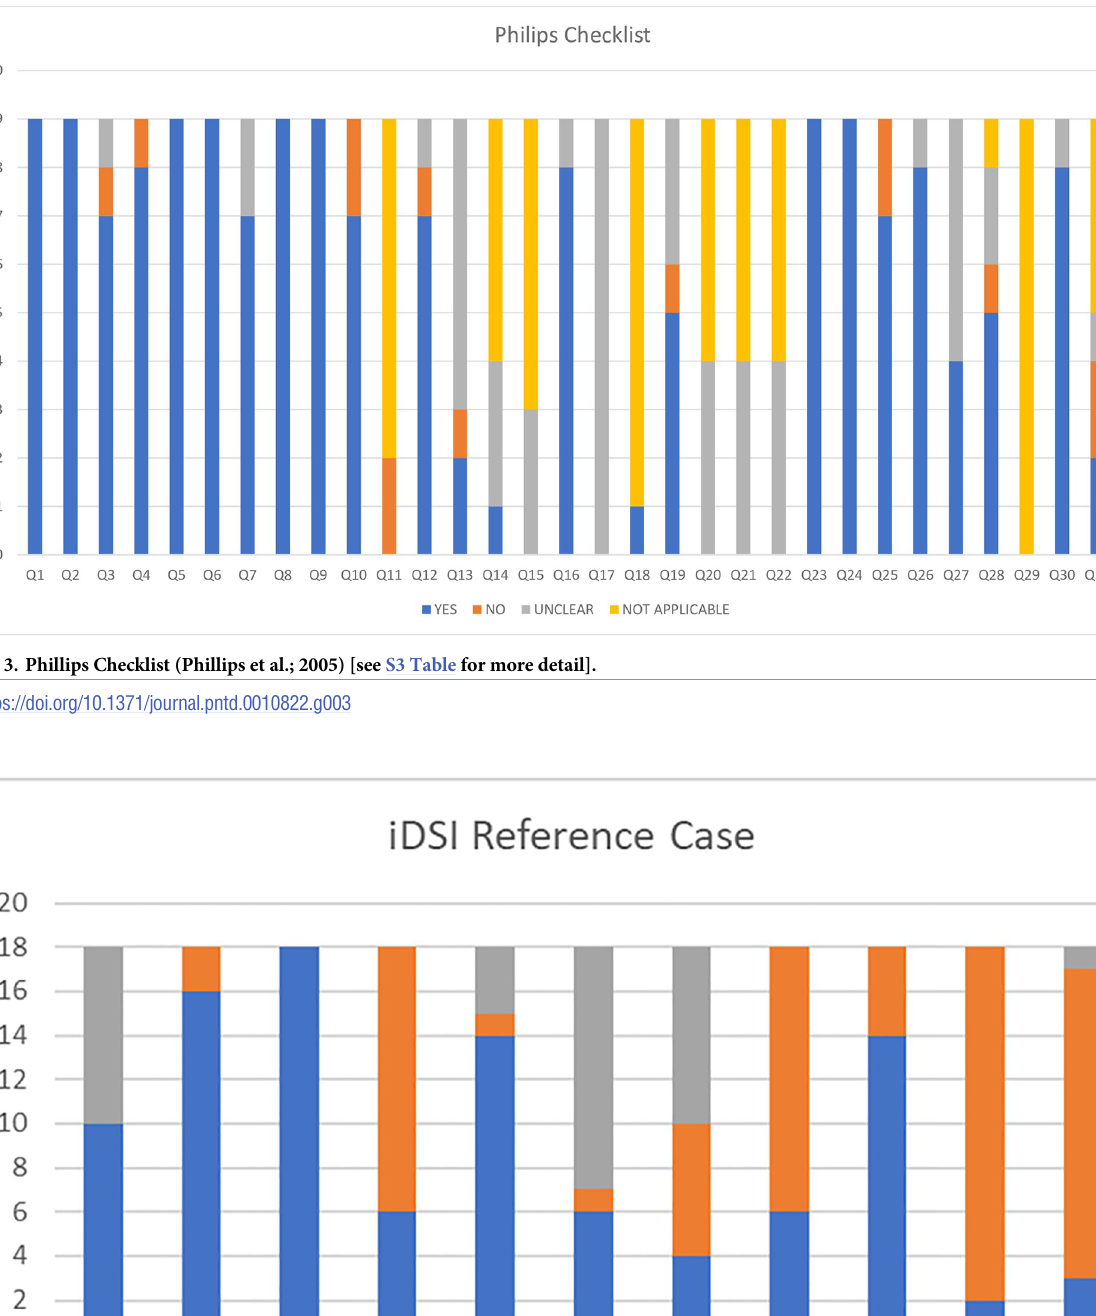
PLOS NeglectedTropical Diseases | https://doi.org/10.1371/journal.pntd.0010822 October 12, 2022 17 /